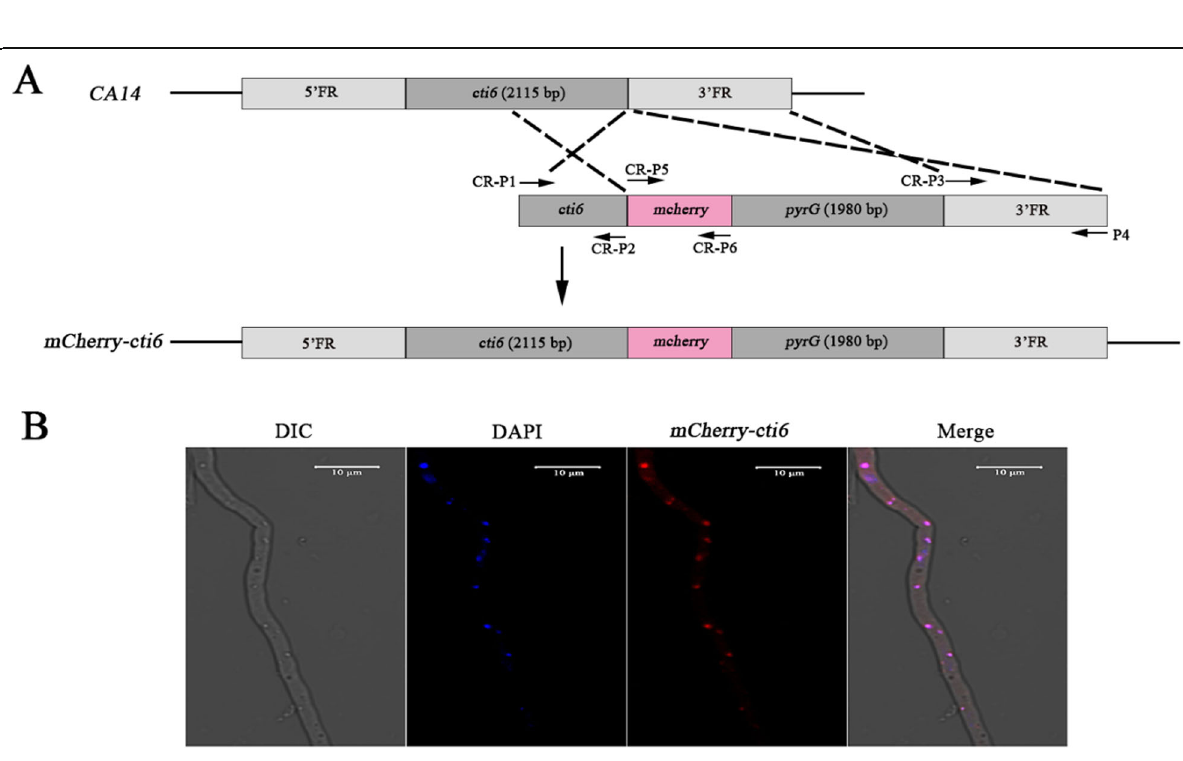
Fig. 6 The subcelluar location of Cti6. a The construction strategy for mCherry and cti6 fusion expression A. flavus strain ( mCherry-cti6 ). b The subcellular location of Cti6 was showed through co-expressed